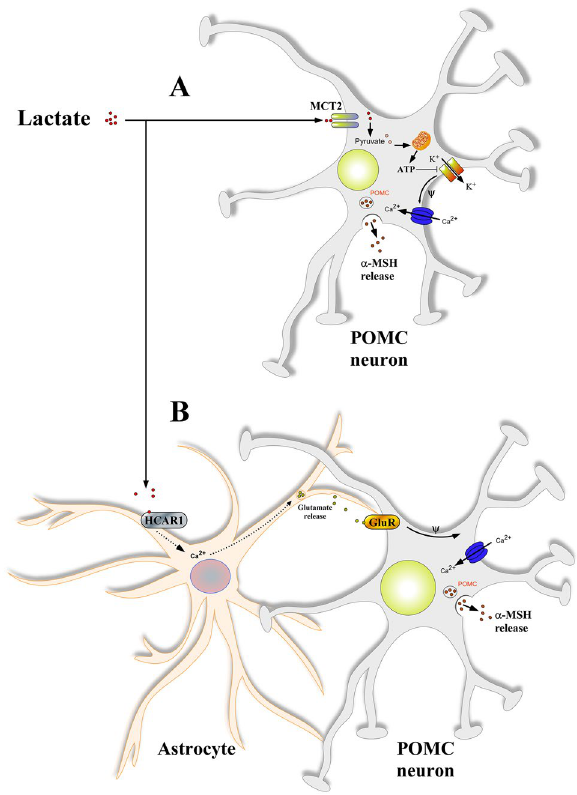
( B ) The binding of lactate to HCAR1 in astrocytes activates a Gi/o-coupled pathway that, through an increase in intracellular calcium, leads to the release of glutamate onto POMC neurons. In this model, the activation of glutamate receptors will cause depolarization of POMC neurons. Dotted line shows a possible mechanism that has not been evaluated